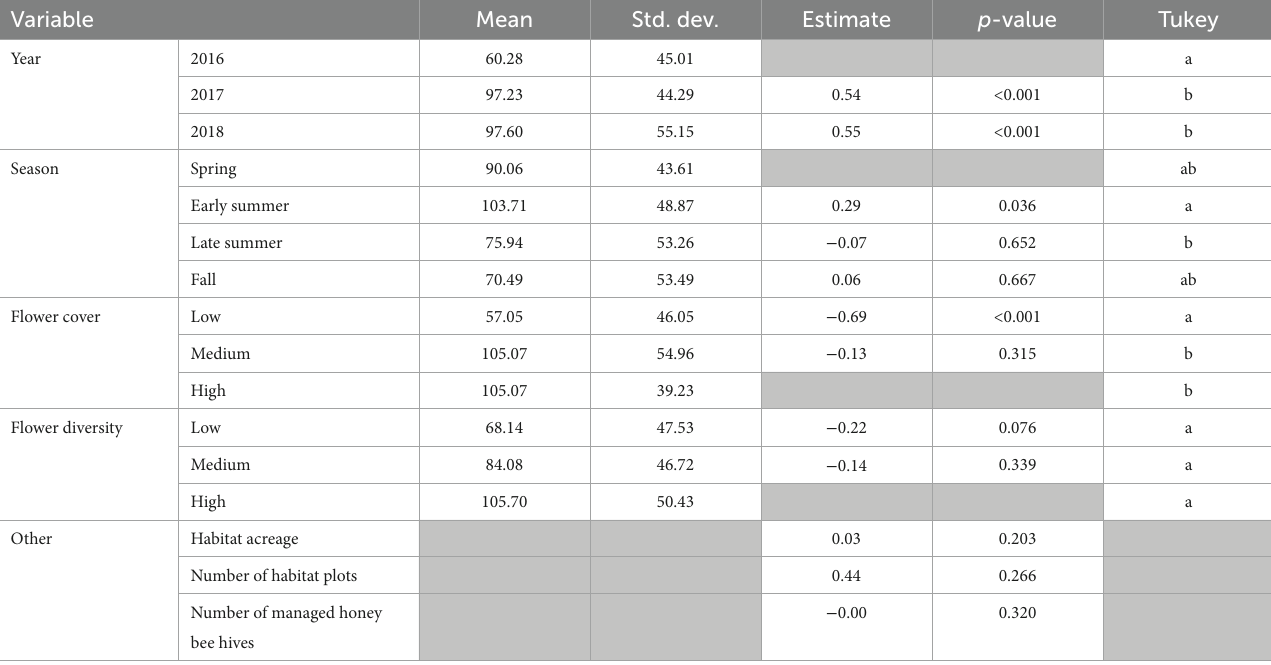
TABLE 2 Output from generalized linear mixed model and Tukey’s post-hoc analysis with abundance as the response with a negative binomial distribution. Variable Mean Std. dev. Estimate p -value